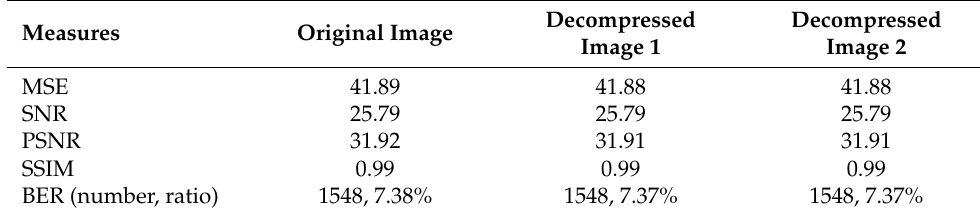
Table 1. Comparative analysis.